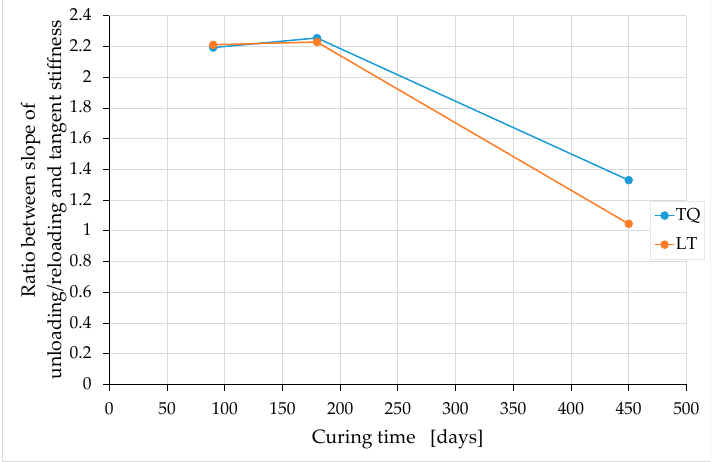
Figure 24. Trend over time of the average values of the ratio between unloading–reloading slope and tangent stiffness at the origin: TQ and LT mixes.